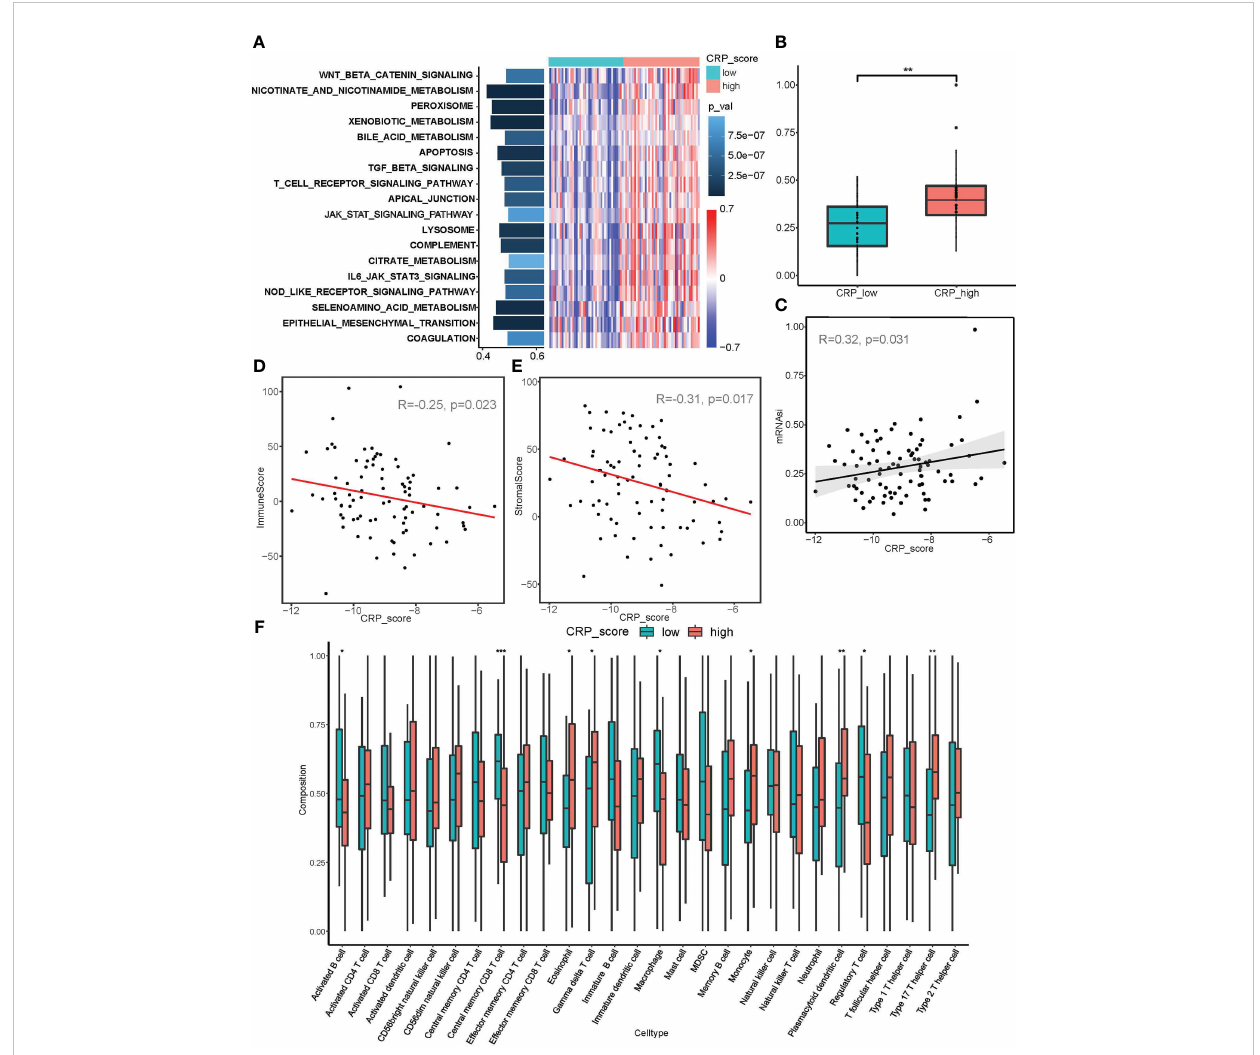
FIGURE 5 Correlation analysis between CRP score and malignant biological behaviors. (A) GSVA analysis showed diverse enriched pathways between CRP_high and CRP_low subgroups. (B, C) mRNAsi index analysis revealed differences in stemness properties between CRP_high and CRP_low subgroups and a signi fi cant correlation between CRP_score and mRNAsi. (D, E) ESTIMATE analysis for the correlation between CRP_score and immune cell in fi ltration as well as a stromal component in samples of the TARGET_OS dataset. (F) ssGSEA for the in fi ltration analysis of 29 types of immune cells in CRP_high and CRP_low subgroups *P < 0.05; **P < 0.01; ***P <